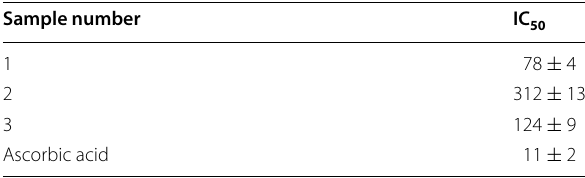
Table 2 The in vitro antioxidant activity of